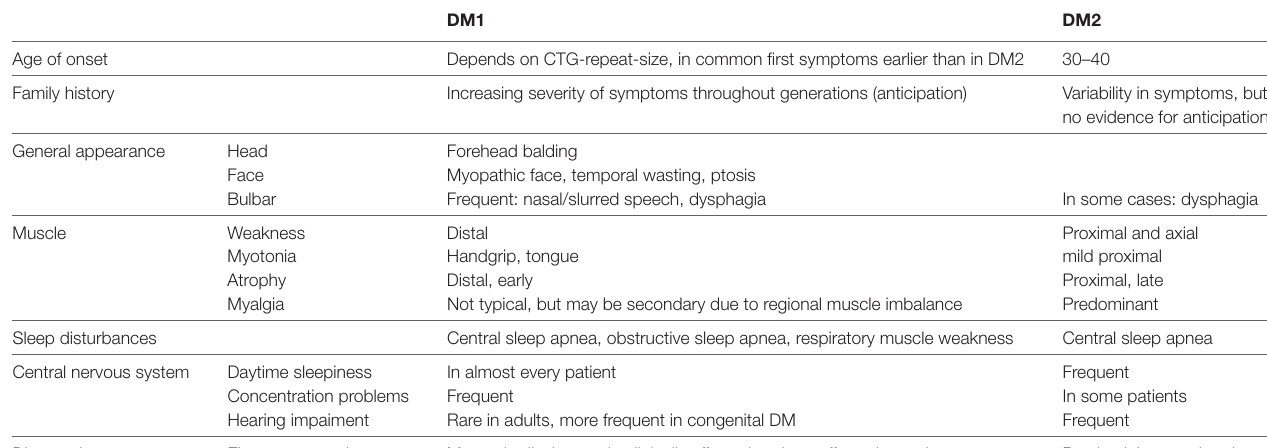
TABLe 2 | Core Clinical Symptoms helpful for differentiating DM1 and DM2.